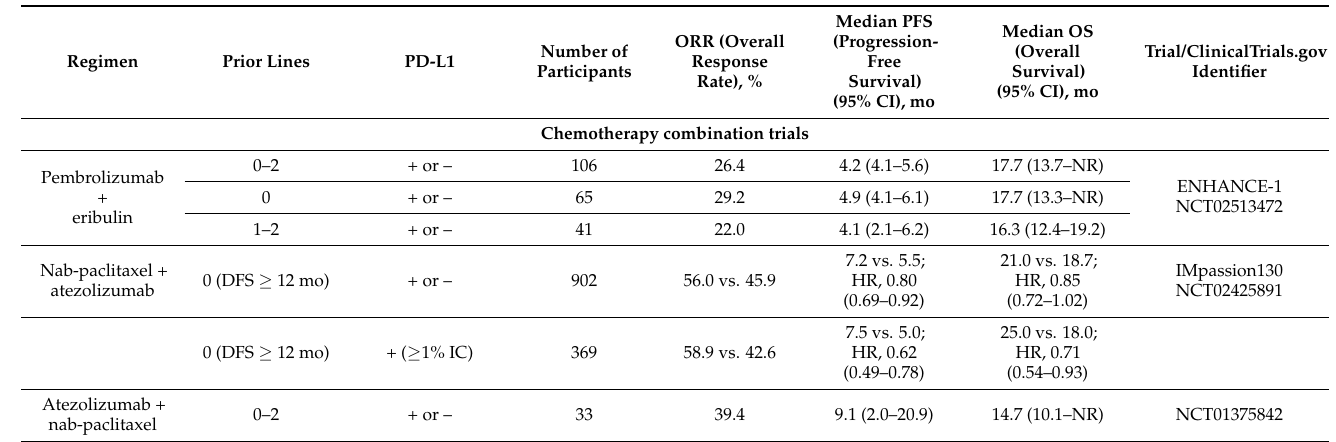
Table 6. Resulted targeted therapy and novel immunotherapy agent anti-PD-1/L1 trials in metastatic TNBC.